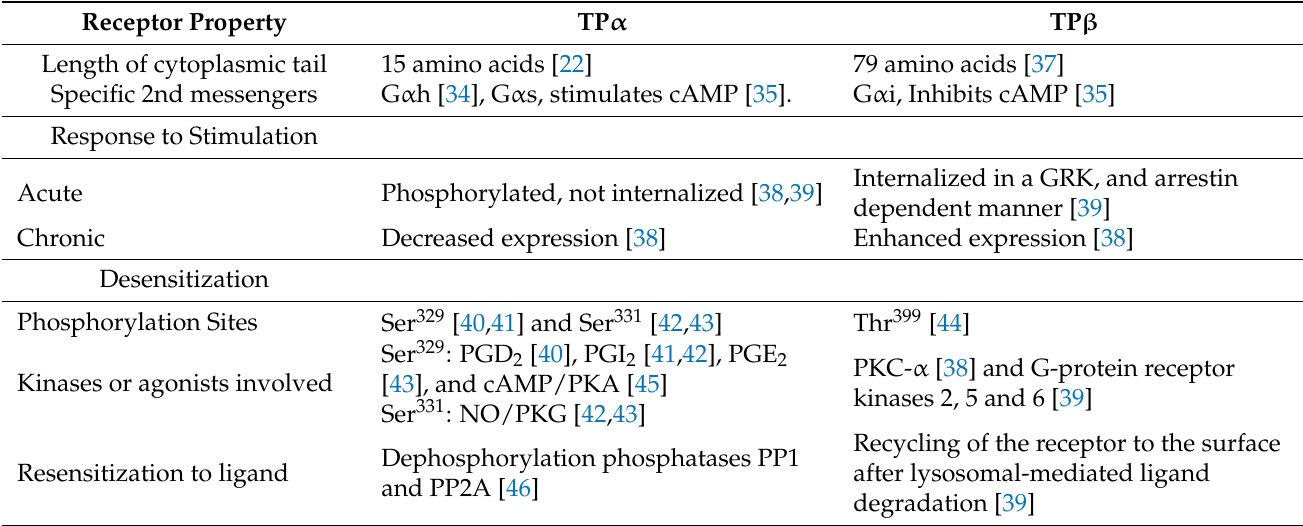
Table 1. Divergent biological properties of the two human TP